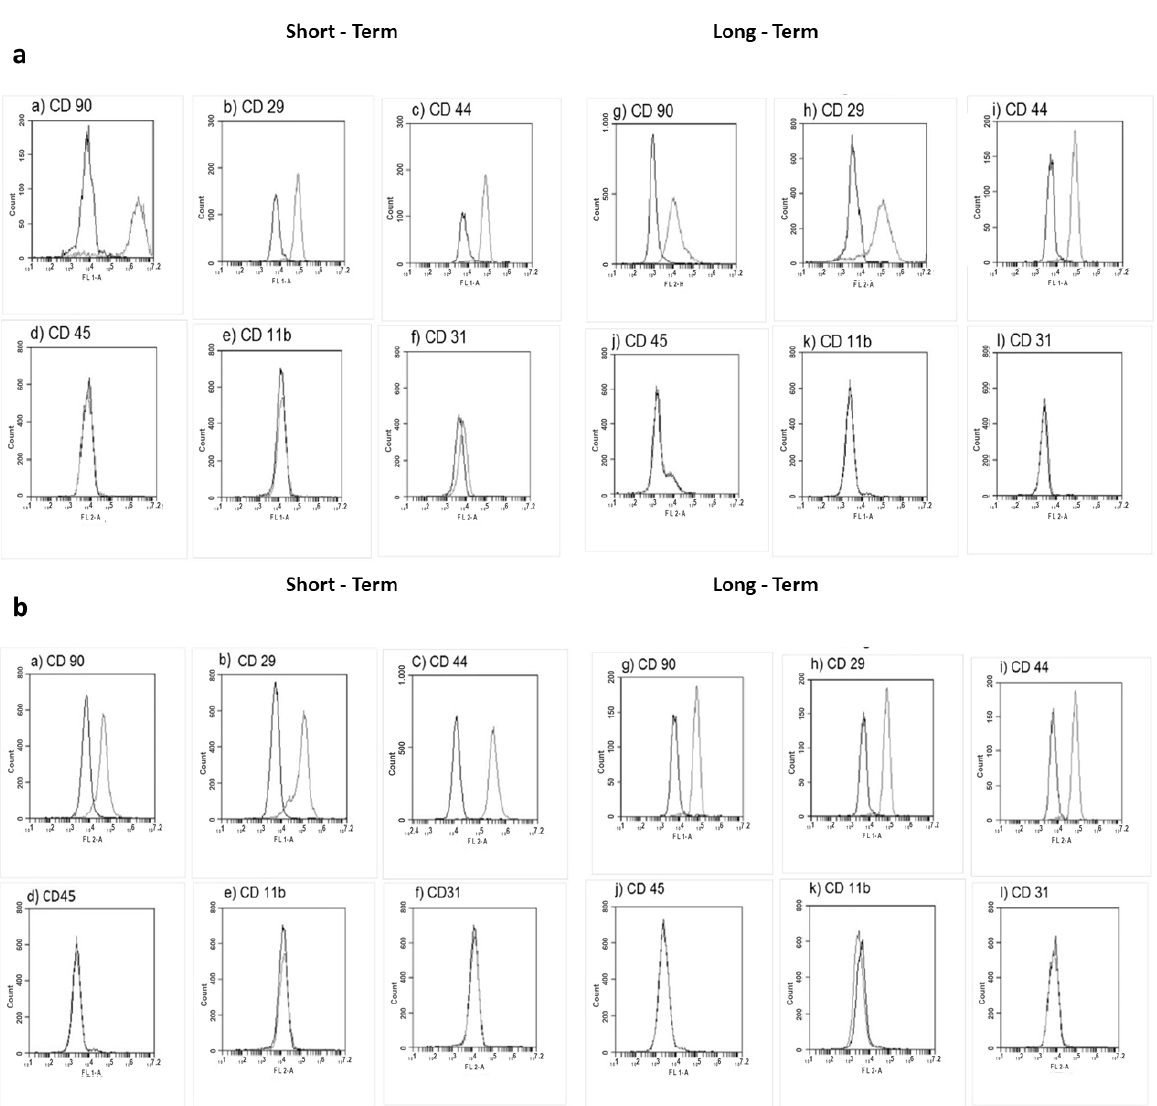
Figure 2. Immunophenotypic profile of short- and long-term cultures ASC (2a) and BMSC (2b), showing fluorescence positivity for CD90 (a, g), CD29 (b, h) and CD44 (c, i) markers (darker color peaks) in relation to histogram control (peak of lighter color). And low fluorescence for CD45 (d, j), CD11b (e, k) and CD31 (f, l) markers. The control histogram corresponds to cells not labeled with